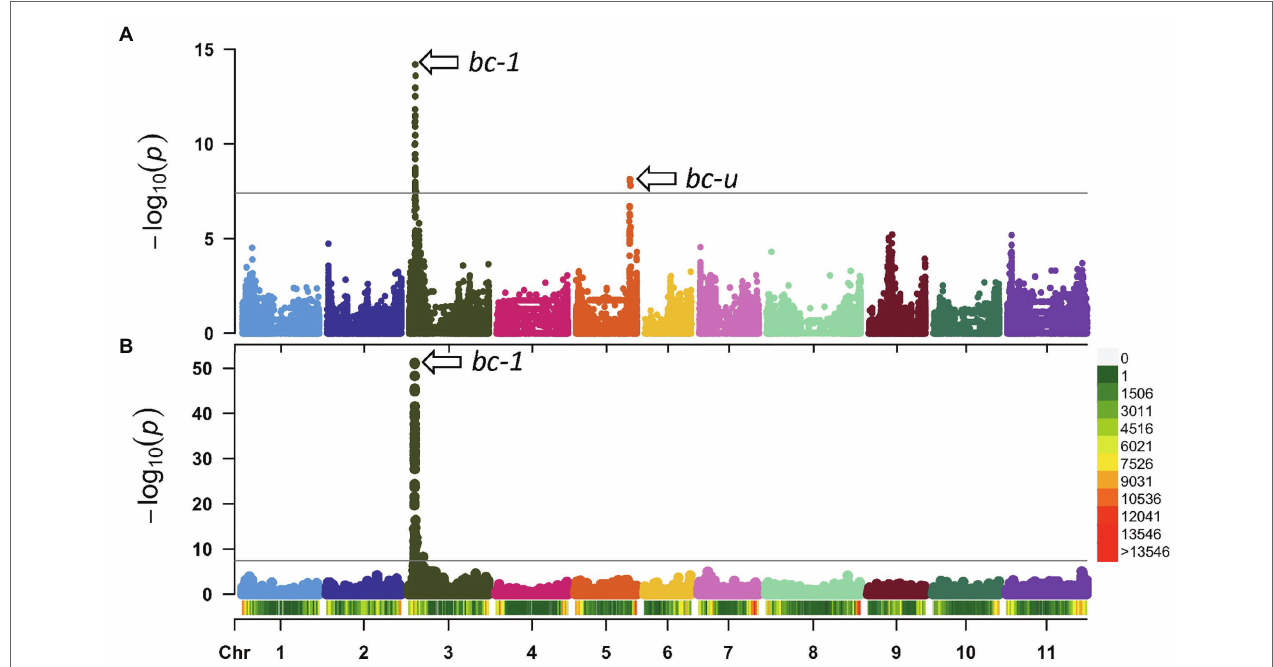
FIGURE 1 | Manhattan plots of common mosaic necrosis virus (BCMNV) resistance in DDP. The gray horizontal line represents the genome-wide significance threshold of p = 3.98 × 10 − 8 . (A) genome-wide association study (GWAS) using lines exhibiting mild mosaic (mM) and lines with mosaic (M) symptoms inoculated with NL-3 strain, two strong associations on Pv03 ( bc-1 ) and Pv05 ( bc-u d ). (B) GWAS using lines with no symptoms (NS) compared with lines showing mosaic (M) symptoms against NL-8 strain, peak detected on Pv03 ( bc-1 ). Bottom: Density bar (color-coded) showing genome distribution of 1,269,044 biallelic SNPs within 1 Mb window size in the